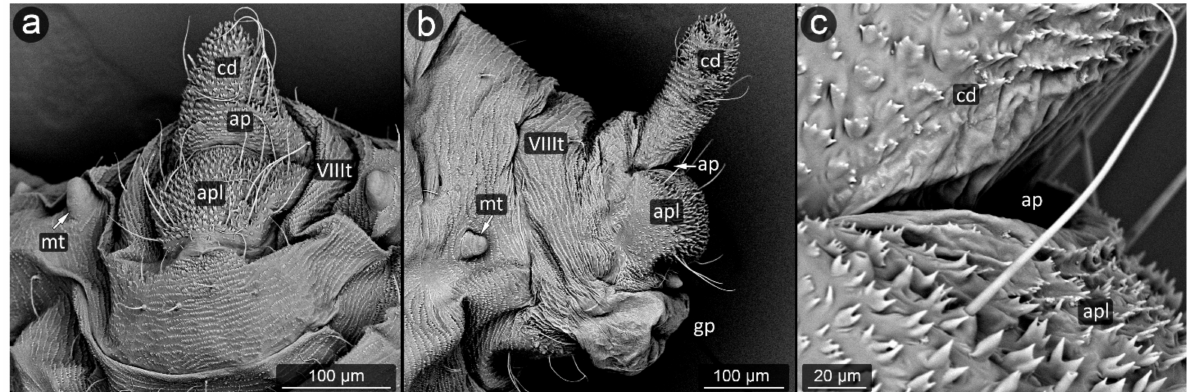
Figure 11. Perianal structure of Aphis pomi in SEM; ( a )—rear–abdominal view, ( b )—lateral view, ( c )—close-up on the surface of anal plate and cauda-protruding spinules. Abdominal tergite VIII: with dense, fine microsculpture, two short setae with pointed apices at the cauda base are present.